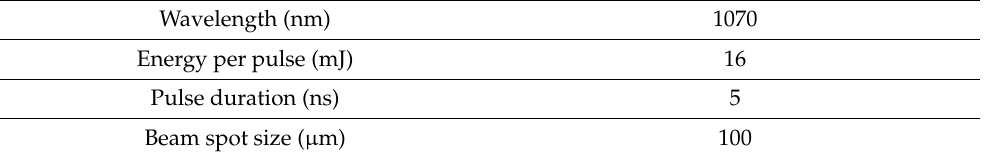
Table 2. Laser parameters.